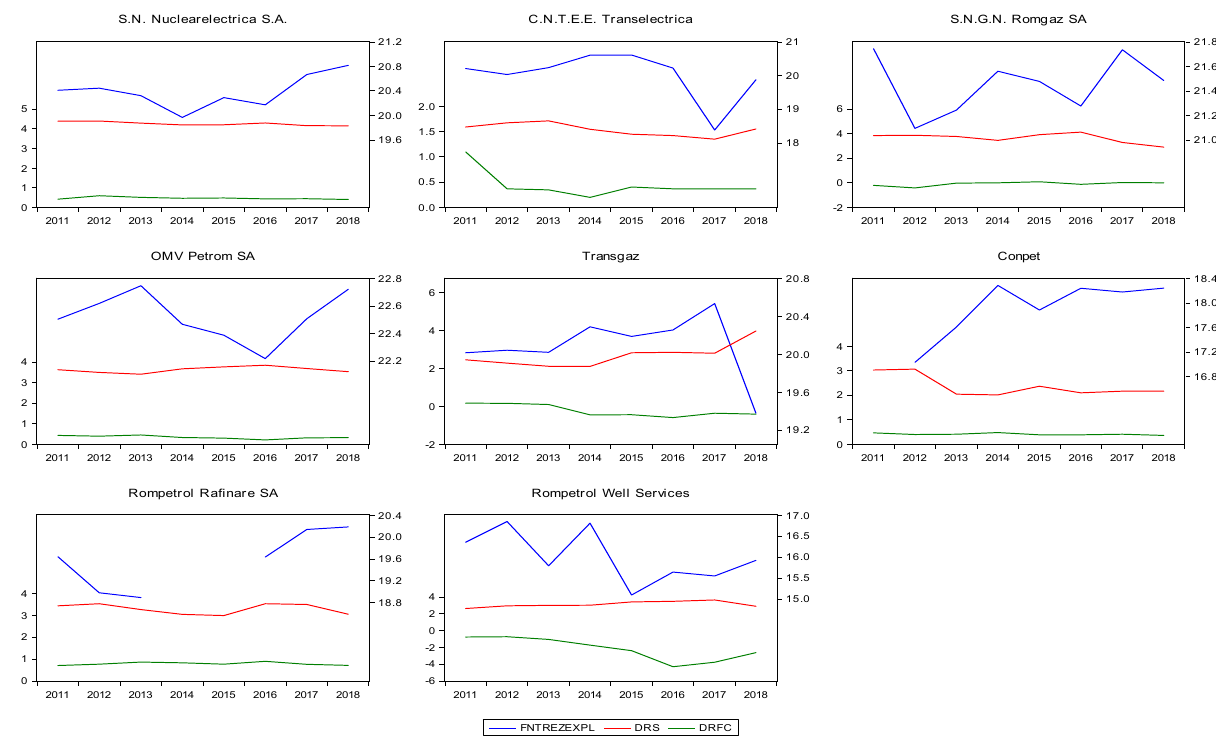
Figure 2. Evolution of the FNTREZEXPL (right axis) and the DRS and DRF_C (left axis) for the analyzed panel. Source: authors’ construction in Eviews 7. Figure 3 reflects a similar evolution for the operating cash flow, return on equity, and labor productivity, in the case of all the assessed companies.